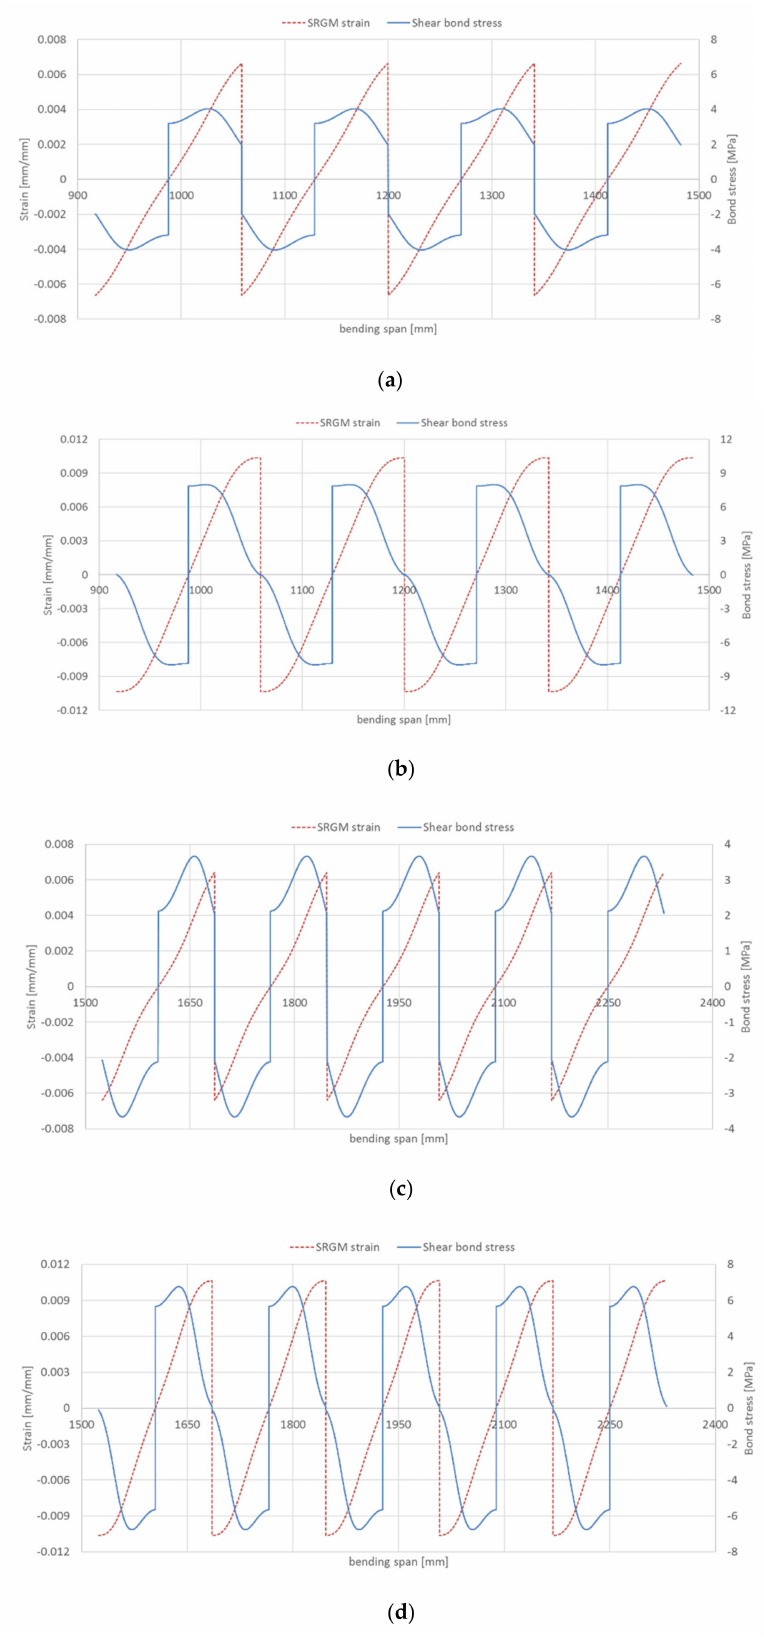
Figure 13. Intermediate debonding prediction at steel strip–matrix interface (half bending